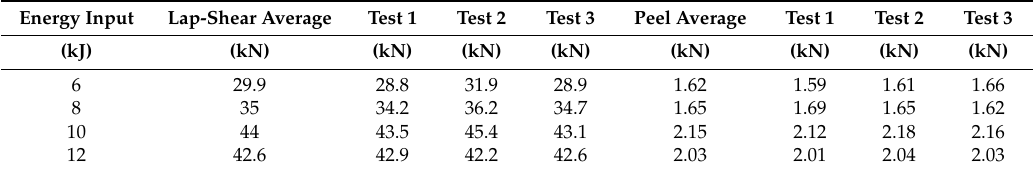
Table 2. Lap-shear and peel test results.